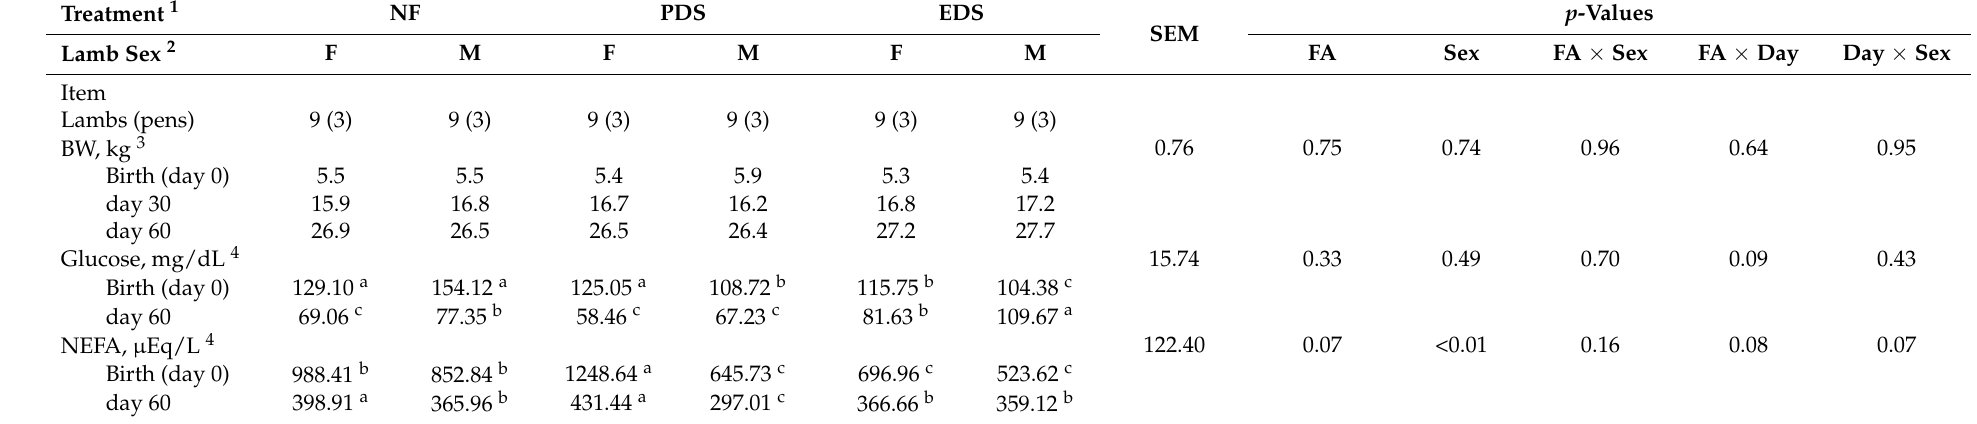
Table 5. Effect of a fatty acid enriched diet during the last 50 days of gestation on body weight (BW), and plasma metabolites from birth to weaning in male (M) and female (F)